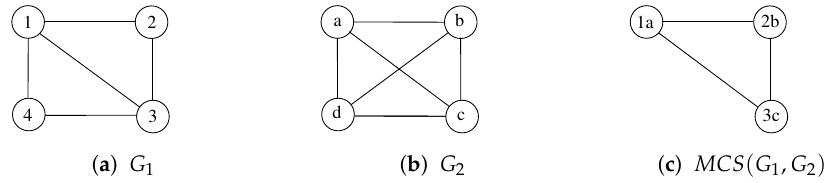
Figure 2. Two undirected and unlabeled graphs G 1 , G 2 , and one possible common subgraph computed by McSplit. Node labels, i.e., { 1,2,3,4 } and { a , b , c , d } , are reported to uniquely identify all